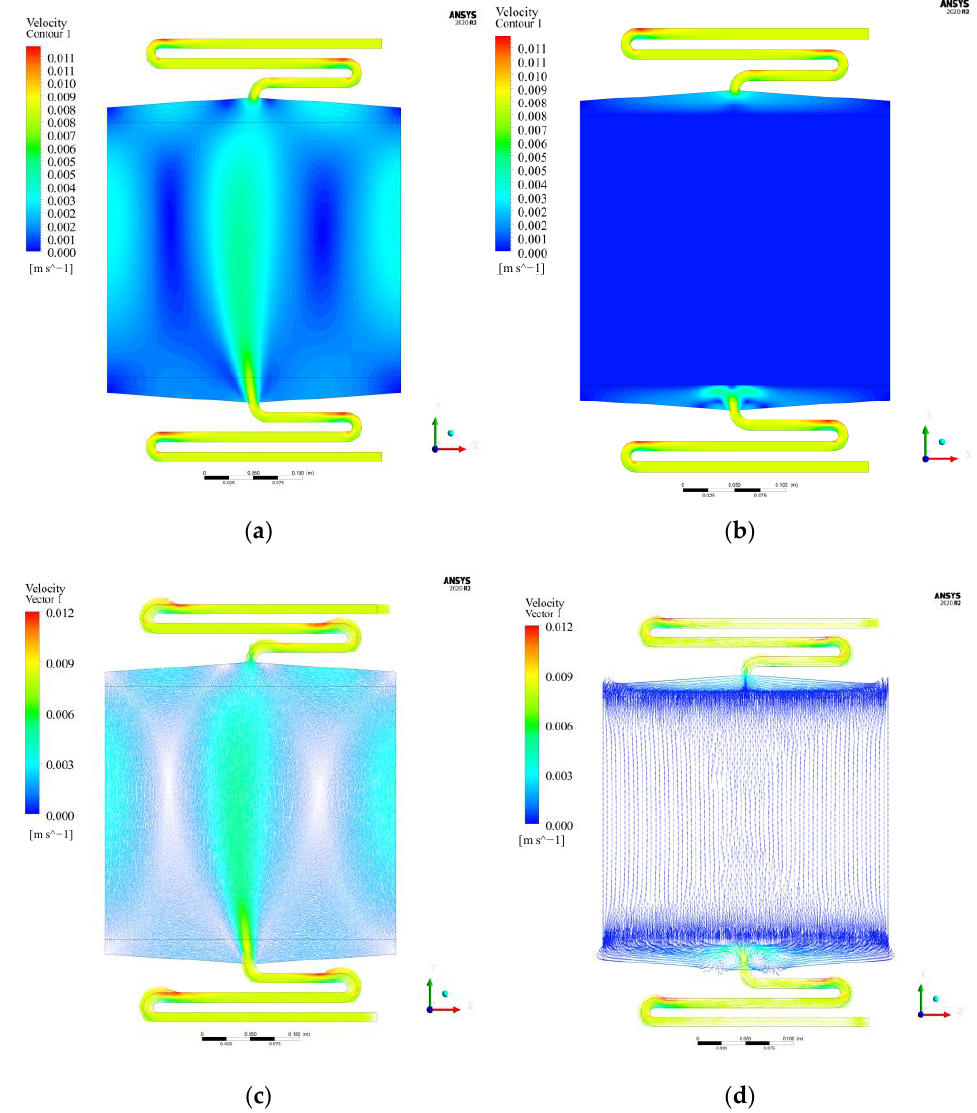
Figure 2. The velocity distribution. ( a ) Velocity contours without porous electrode; ( b ) velocity contours with porous electrode; ( c ) velocity vectors without porous electrode; and ( d ) velocity vectors with porous electrode.